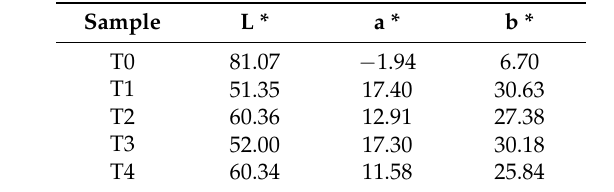
Table 1. Colorimetric coordinates of textile samples.